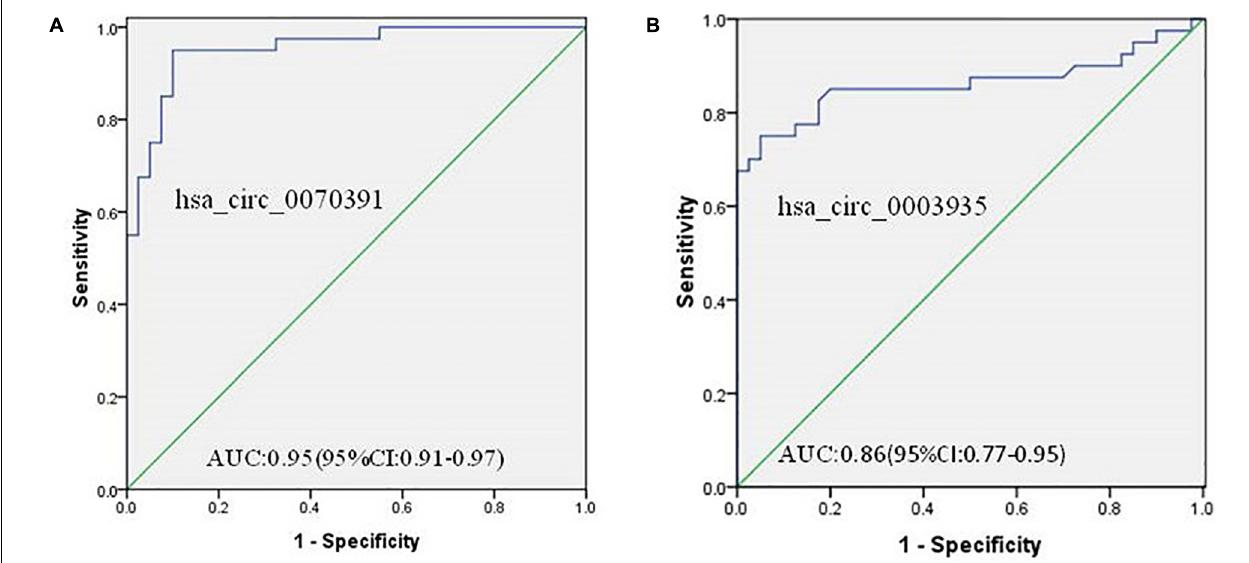
FIGURE 8 | The diagnostic value of circRNAs for AF and diagnostic value to differentiate persistent from paroxysmal AF using the receiver operating characteristic (ROC) curve analysis. (A) The diagnostic value of hsa_circ_0070391 for AF and (B) the diagnostic value of hsa_circ_0003935 for